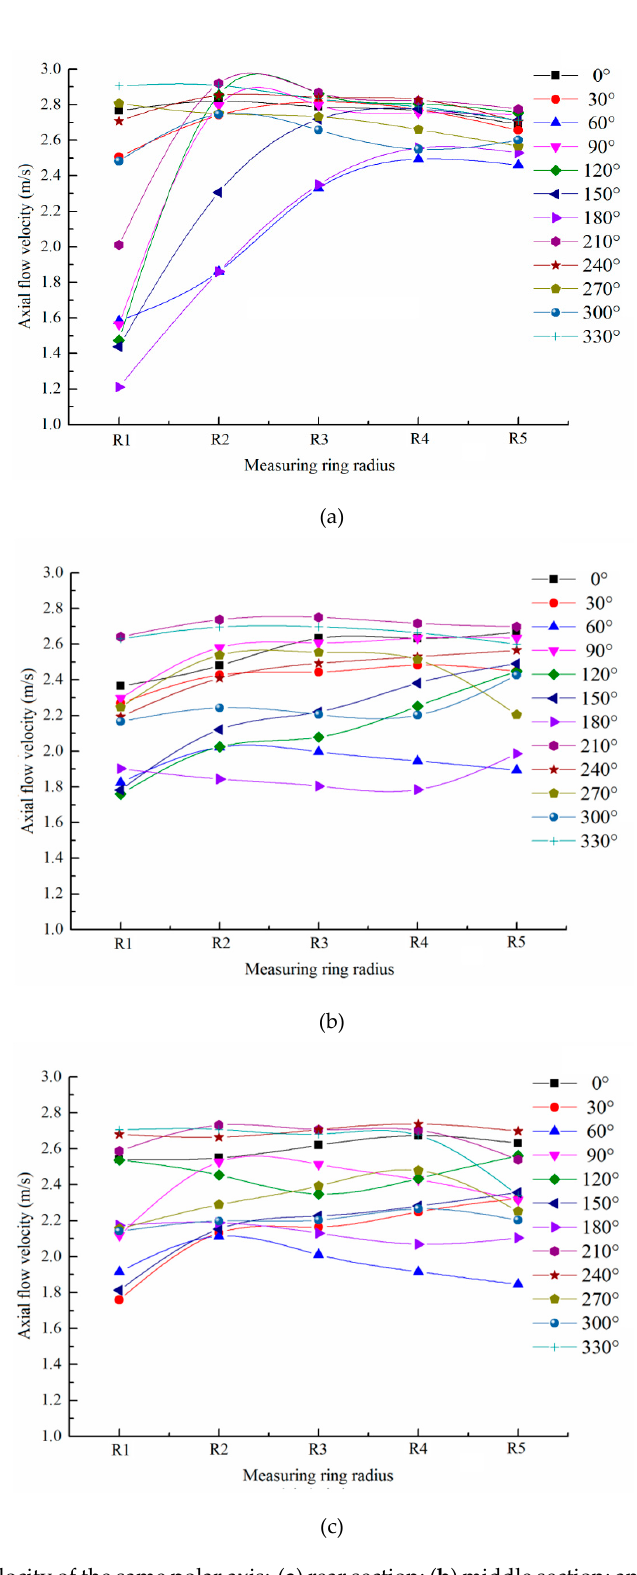
Figure 12. Axial velocity of the same polar axis: ( a ) rear section; ( b ) middle section; and ( c ) front